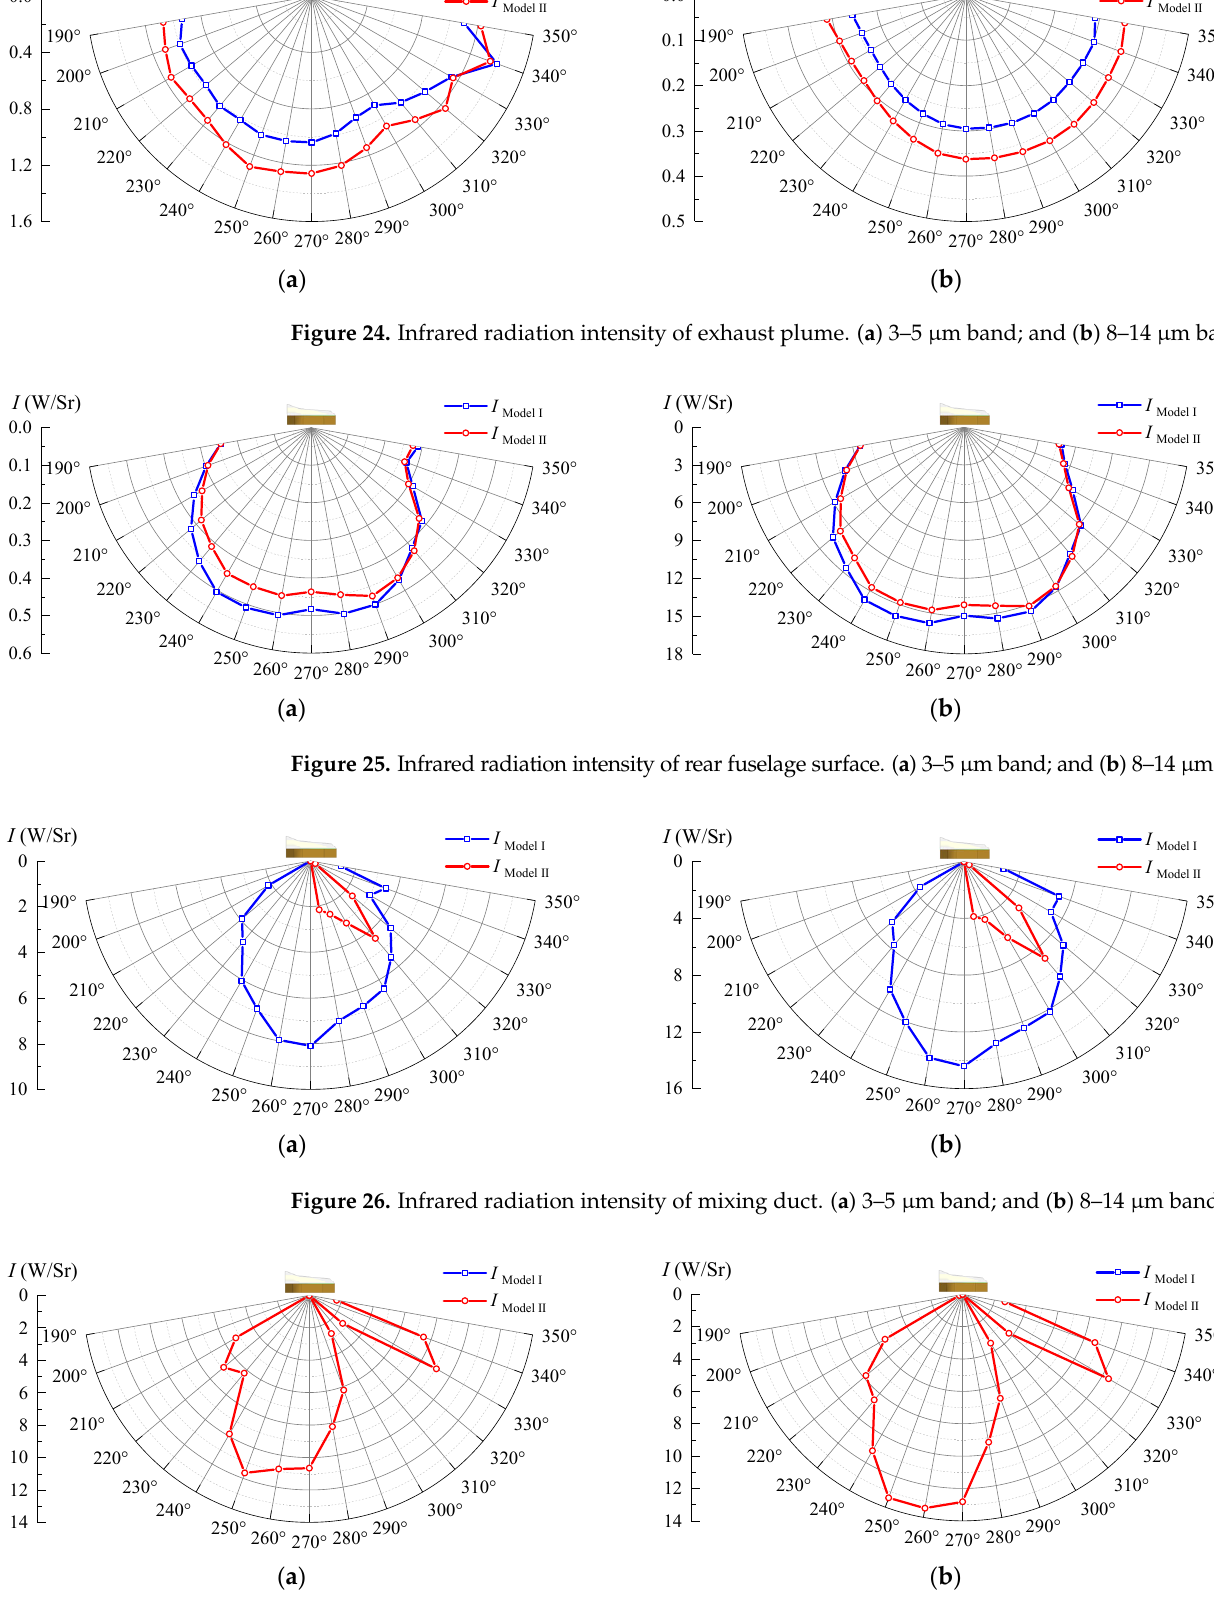
Figure 27. Infrared radiation intensity of de fl ectors. ( a ) 3–5 µm band; and ( b ) 8–14 µm band. Figure 28 shows the comparison of the total infrared radiation intensities between Model Ⅰ and Model Ⅱ . It can be seen from Figure 23 that the temperature of the de fl ectors in Model Ⅱ mostly exceeds 580 K, and according to Wien’s displacement law, the infrared radiation that is generated by the high-temperature de fl ectors mainly contributes to the 3–5 µm band. Therefore, in Figure 28a, within the detection range where the de fl ectors have a strong blocking e ff ect on the detection rays, the total infrared radiation intensity of the 3–5 µm band of Model Ⅱ is greater than that of Model Ⅰ , due to the large infrared radiation contribution from the de fl ectors. In the 8–14 µm band, the infrared radiations of the two models have li tt le di ff erence. ( a )